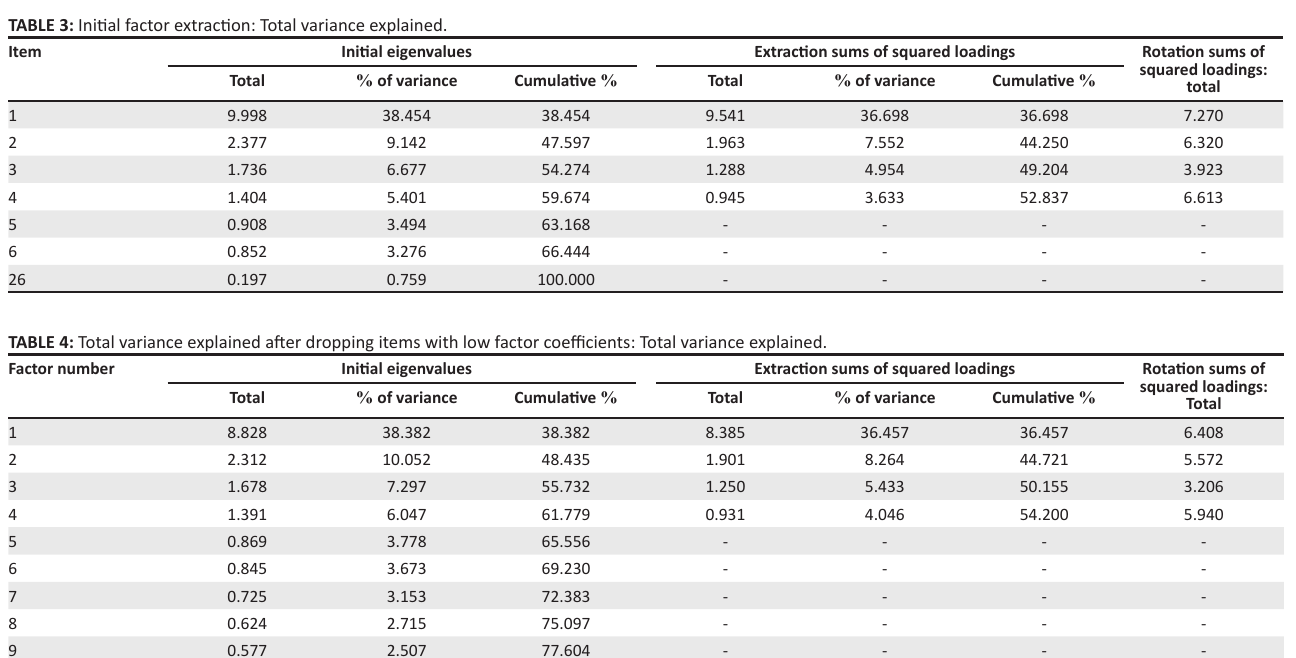
squared loadings: